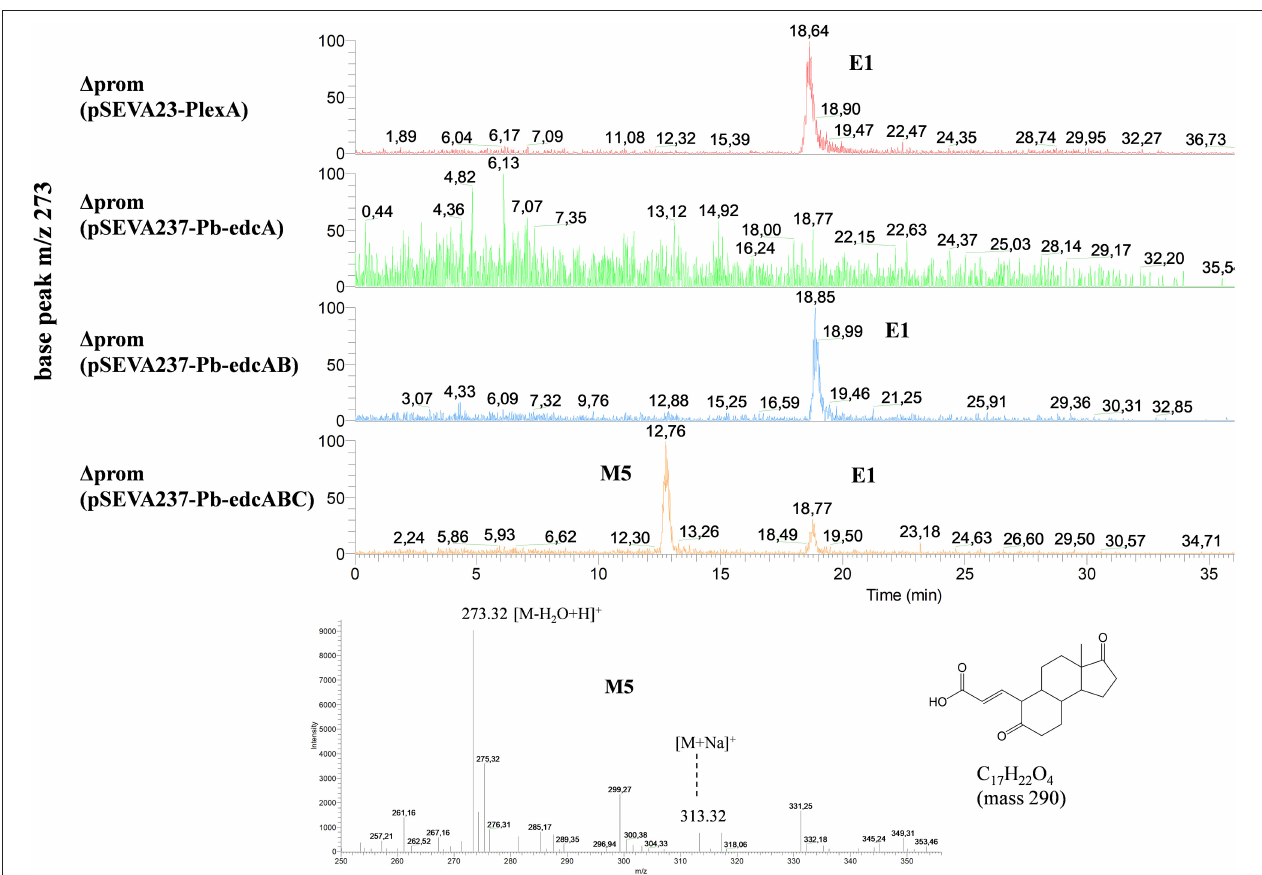
FIGURE 12 | HPLC-MS analysis of the organic phase extracted from cultures of N. tardaugens 1 Prom (pSEVA237-Pb-edcABC) in NB rich medium supplemented with 2mM E1 at 38h. Total ion chromatogram (TIC) of base peak m / z 273 of 1 Prom (pSEVA23-PlexA), 1 Prom (pSEVA237-Pb-edcA), 1 Prom (pSEVA237-Pb-edcAB), and 1 Prom (pSEVA237-Pb-edcABC) and mass spectrum of the peak observed at 12.76min (4-norestrogen-5(10)-en-3-oic